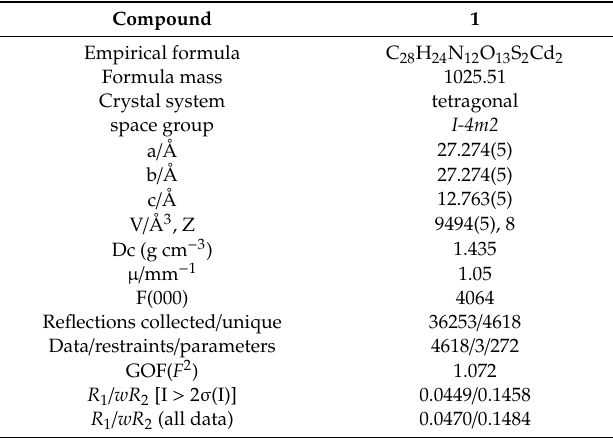
Table 1. Crystallographic parameters for compound 1 .